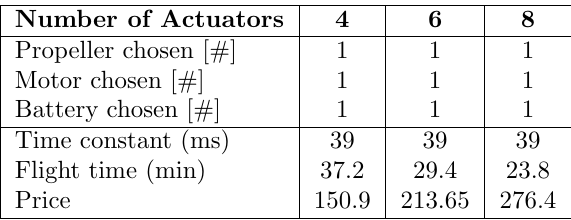
Table 10: Optimization Results: Test Case III. trates the experimental results from Test Case III. The results for Test Case III are similar to Test Case II. Ta- bles 11 and 12 summarize the three different rise times (simulation, acceleration, deceleration). For Test Case III the simulated rise times differ from the measured values by -21ms to +8ms.